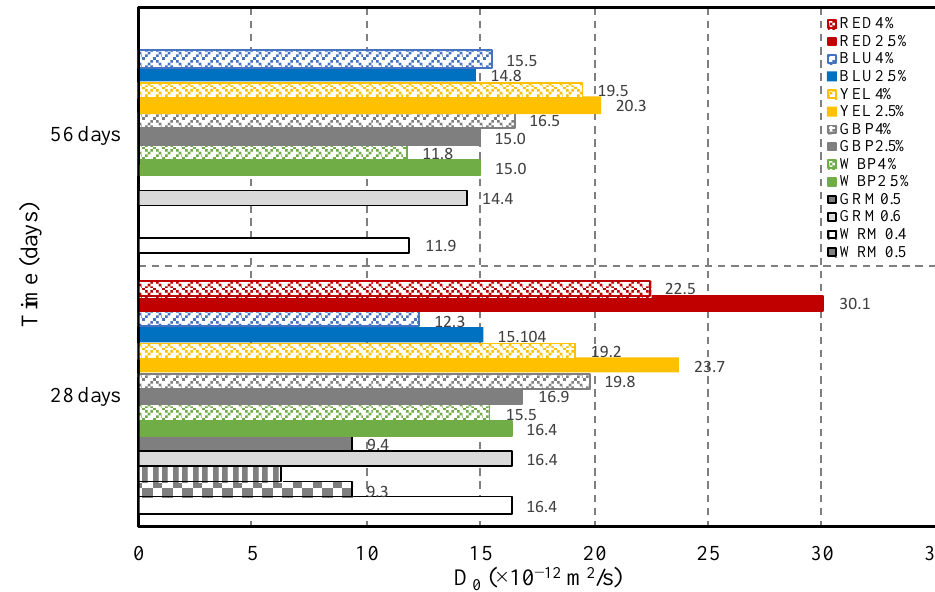
Figure 5. Diffusion coefficients of chlorides (D 0 ), non-stationary migration tests (28 and 56 days).